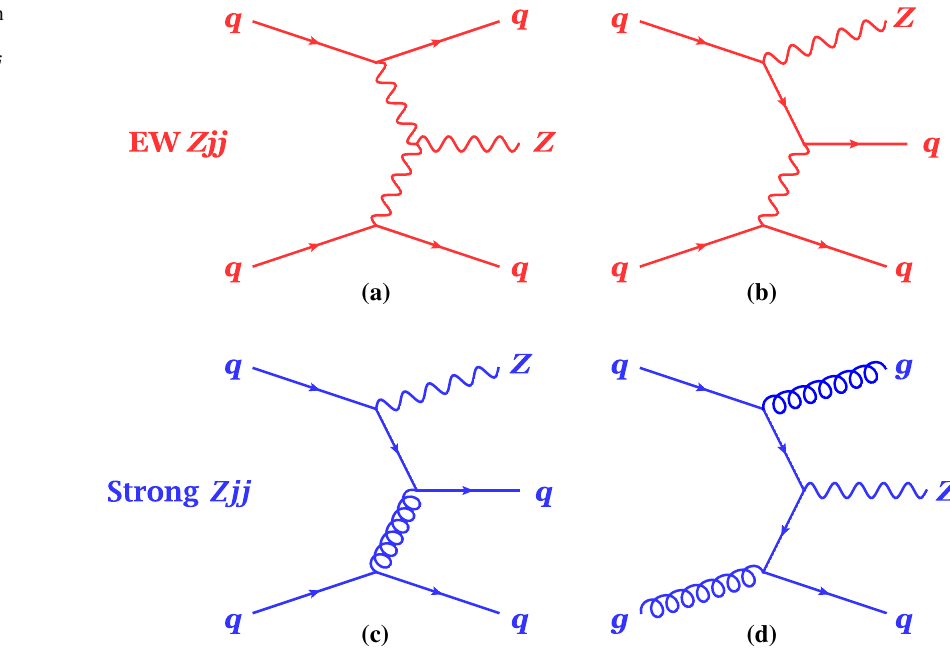
Fig. 1 Representative Feynman diagrams for EW Zjj production ( a , b ) and strong Zjj production ( c , d ). The electroweak Zjj process is defined by the t -channel exchange of a weak boson and at tree level is calculated at ) when including the O (α 4 EW decay of the Z boson. The strong Zjj process has no weak boson exchanged in the t -channel and at tree level is α s 2 ) when calculated at O (α 2 EW including the decay of the Z